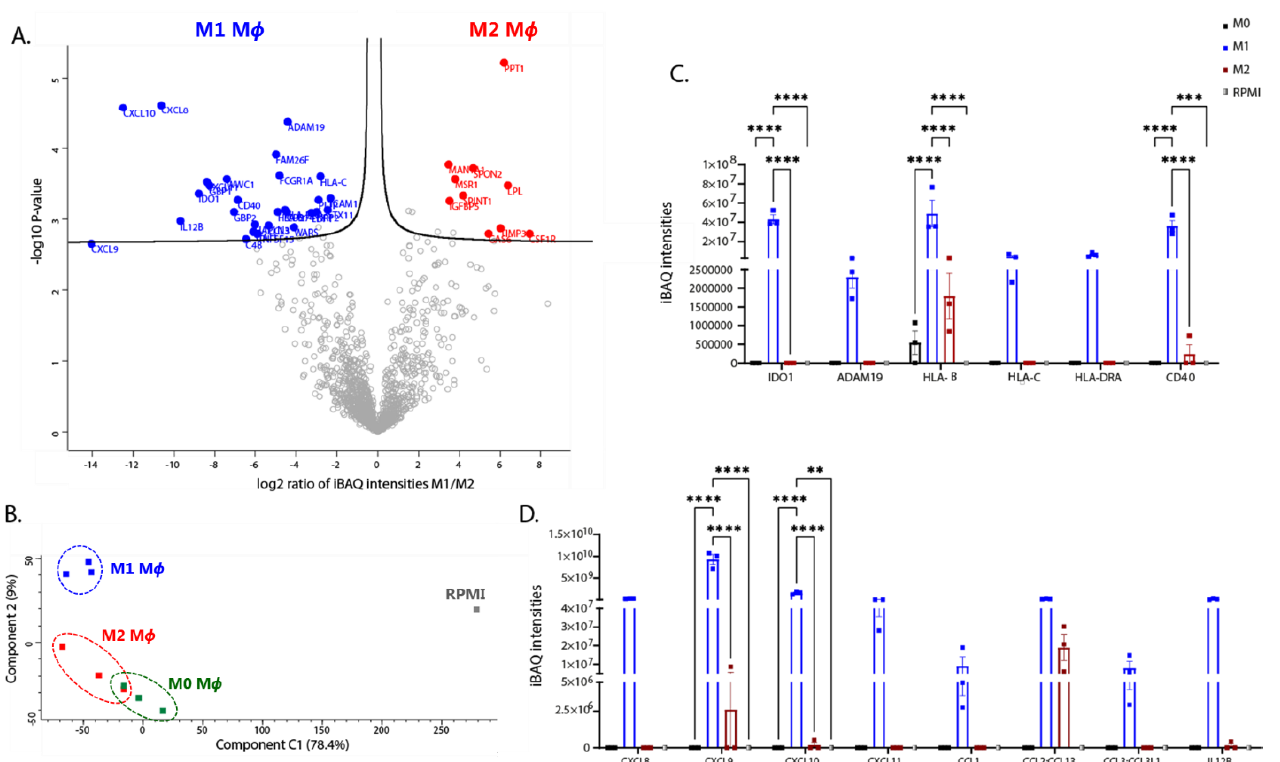
Figure 9. Secretome analysis of polarised iPSDM. ( A ) Volcano plot showing fold change changes in secreted proteins using log-transformed iBAQ intensities vs. log-transformed p values. ( B ) Principal component analysis plot showing clustering of the iPSDM secretome according to polarisation. ( C , D ) Histograms showing iBAQ intensities of cytokines/chemokines and other immune modulators. p values: ** 0.01, *** 0.001, **** 0.0001.